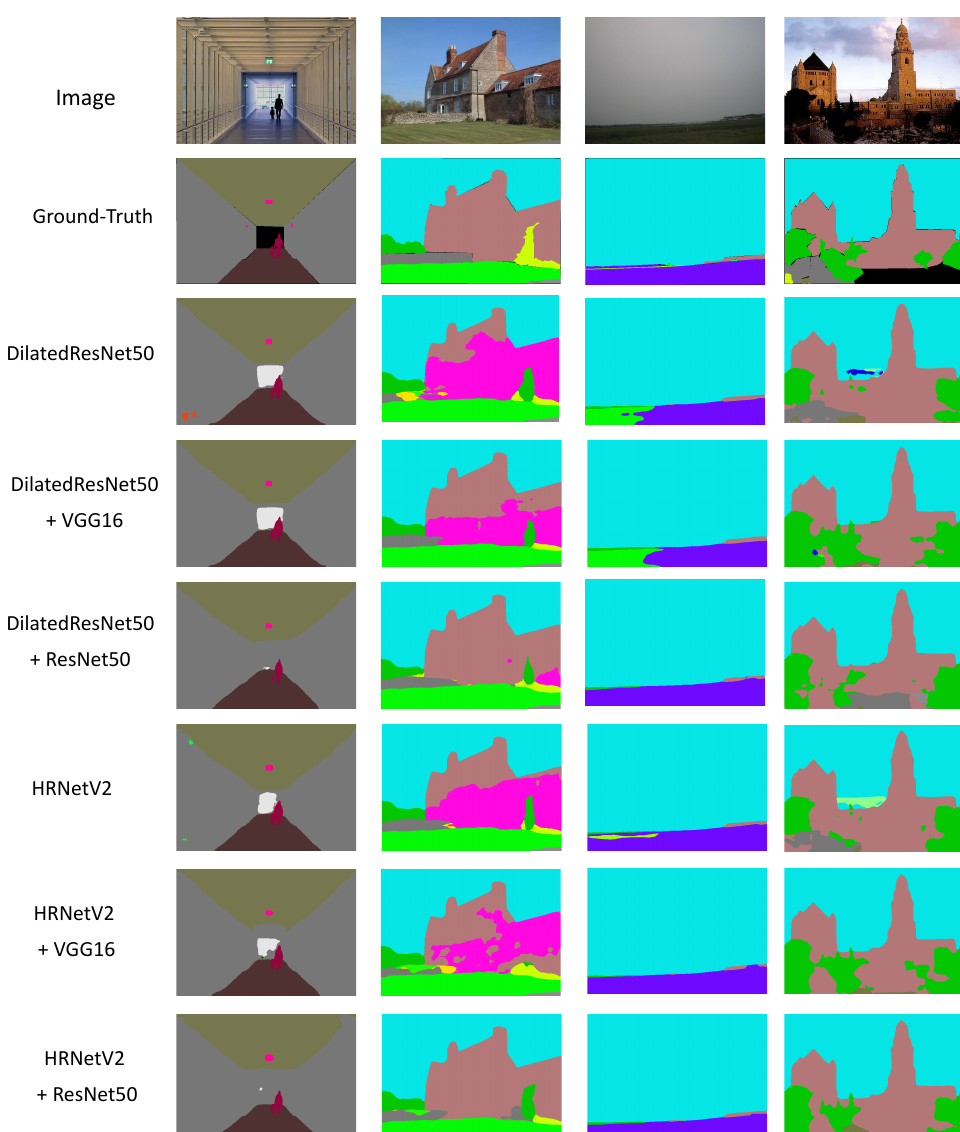
Figure 6. Ground-truth and qualitative results of proposed models on the ADE20k validation set. In the predictions of the second column, several models misclassify the brown class into magenta class. The brown class denotes the “building”, and the magenta class denotes “house”. These two classes are similar, so it is easy to lead to